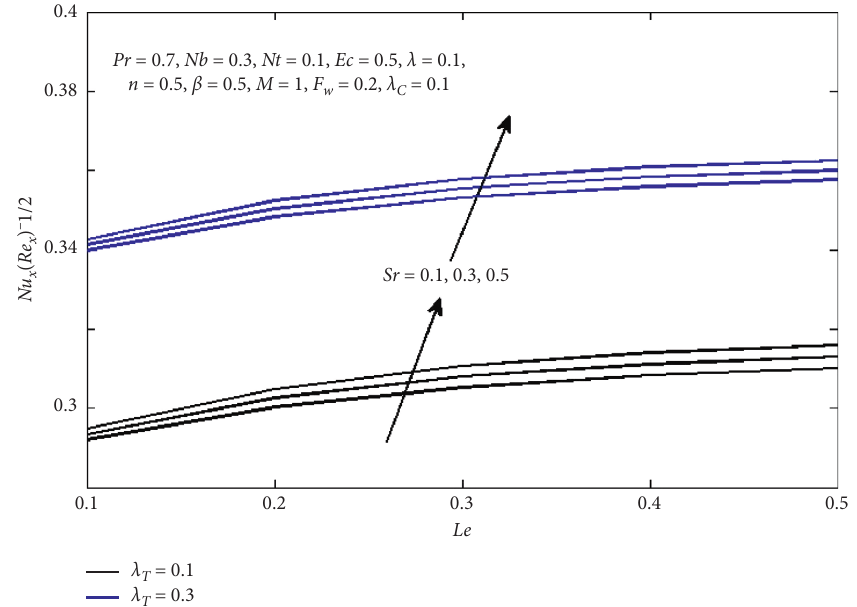
Figure 24: Variation of Nu